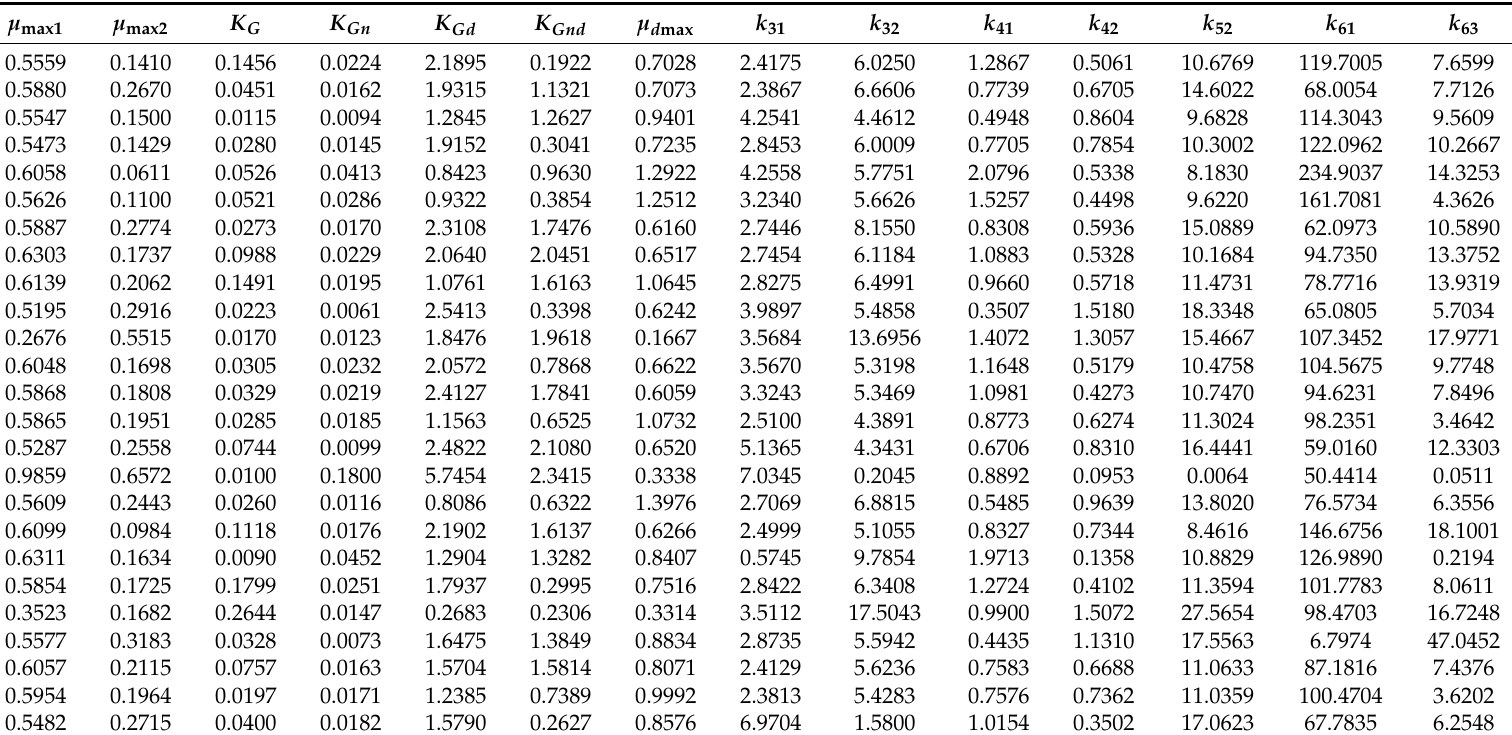
Table A1. Parameter identification following the 25 multi-start runs (orange lines indicate clear local